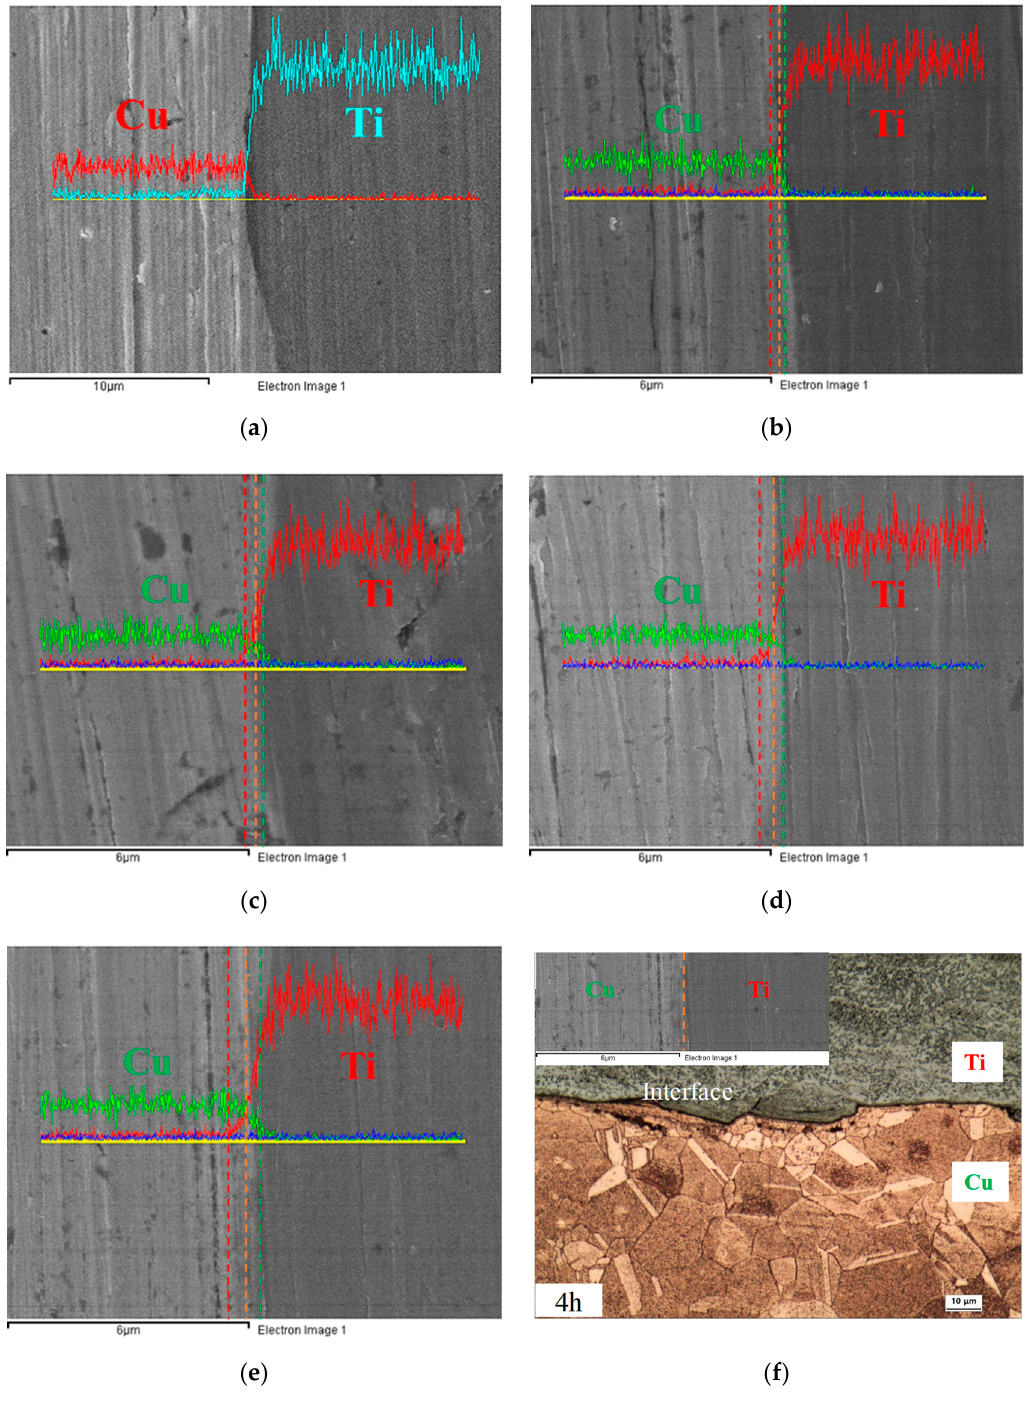
Figure 1. Line scanning analysis results of titanium clad materials: ( a ) as-rolled sample and samples annealed at 450 °C for ( b ) 0.5 h, ( c ) 1 h, ( d ) 2 h, ( e ) 4 h, and ( f ) interfacial microstructure for 4 h.